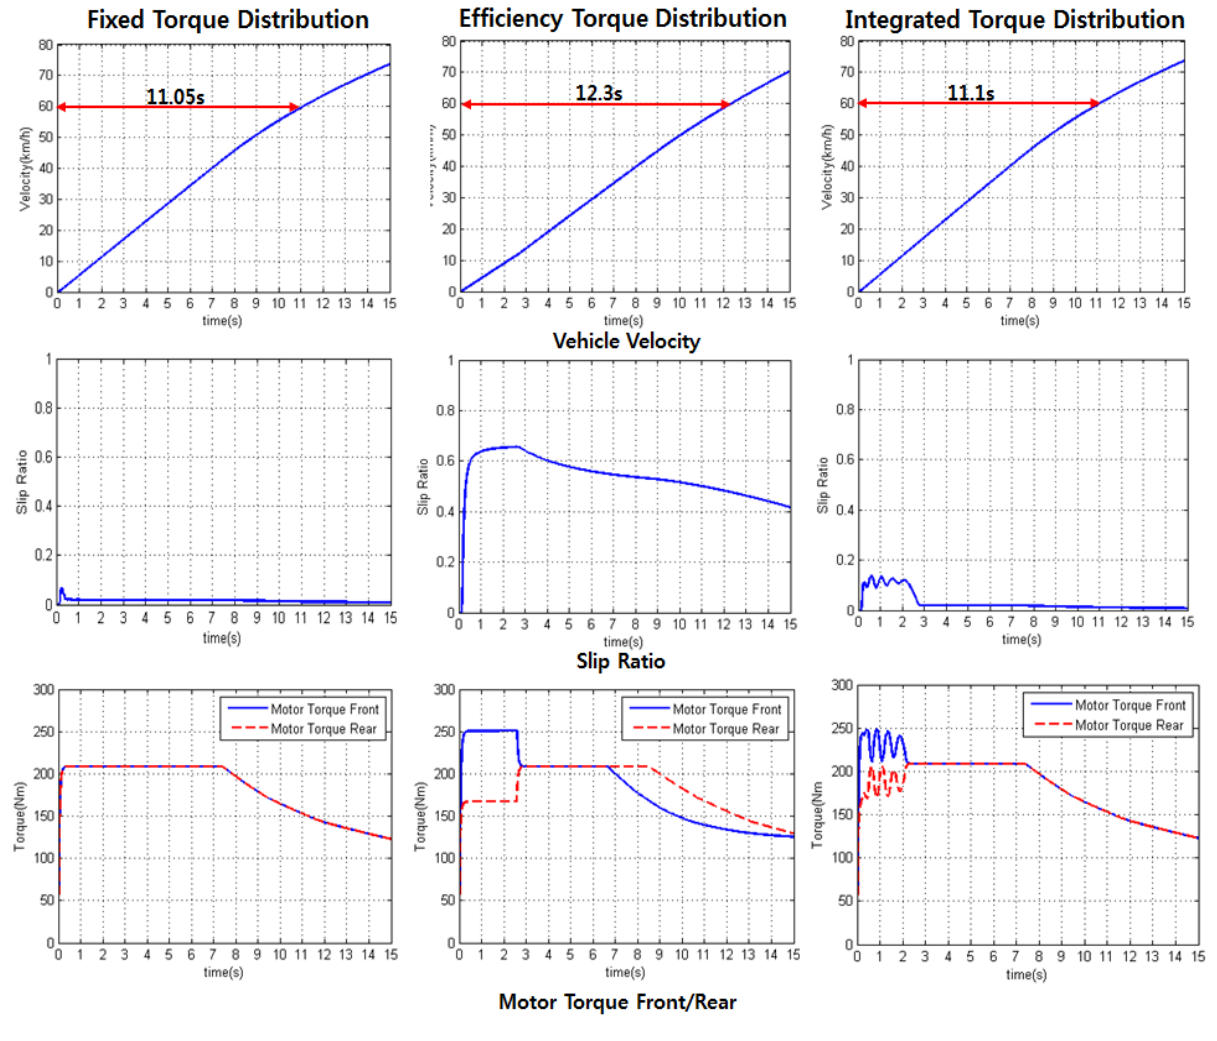
Figure 13. Simulation results of the acceleration situation on a low friction road surface.